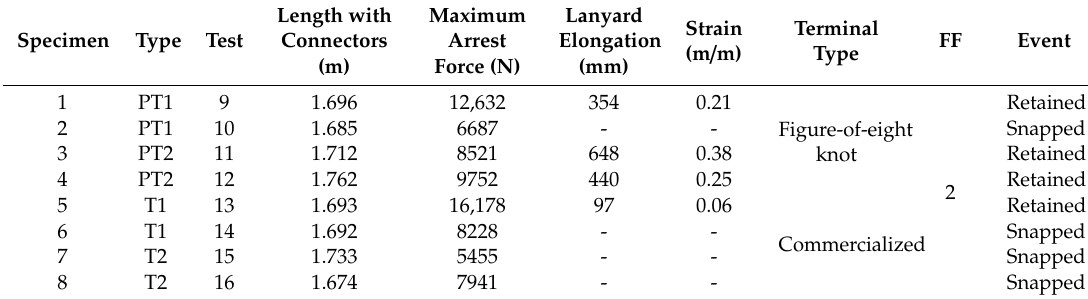
Table 6. Test of specimens. Maximum arrest force and elongation in FF =